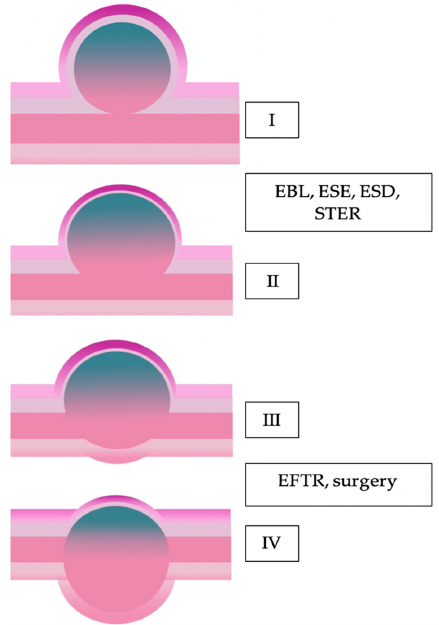
Figure 1. Adapted from Kim et al. Classification of GISTs (gastrointestinal stromal tumors) [7]. Type I—GIST with a very narrow connection with the proper muscle layer and protrudes into the luminal side, like a polyp; Type II—with a wider connection with the proper muscle layer and protrudes into the luminal side at an obtuse angle; Type III—is located in the middle of the gastric wall; Type IV—protrudes mainly into the serosal side of the gastric